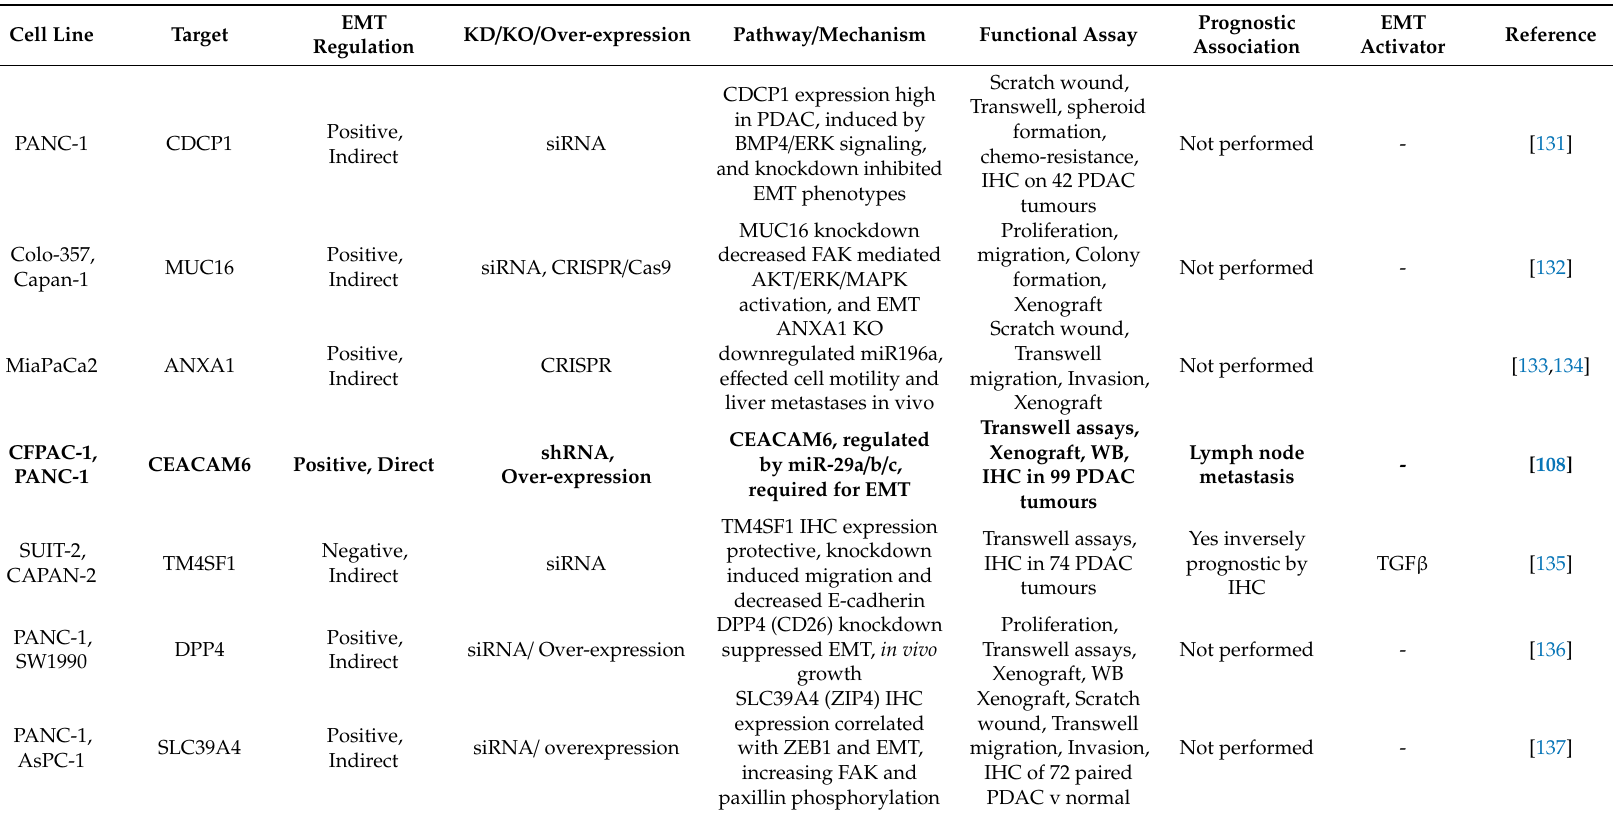
Table 3. Membrane associated proteins. This table describes membrane bound proteins that may interact with other cells and the extracellular environment to sense cues that modulate EMP in a context dependent fashion. Candidates that exhibit clinical correlation with lymph node metastasis are shown in